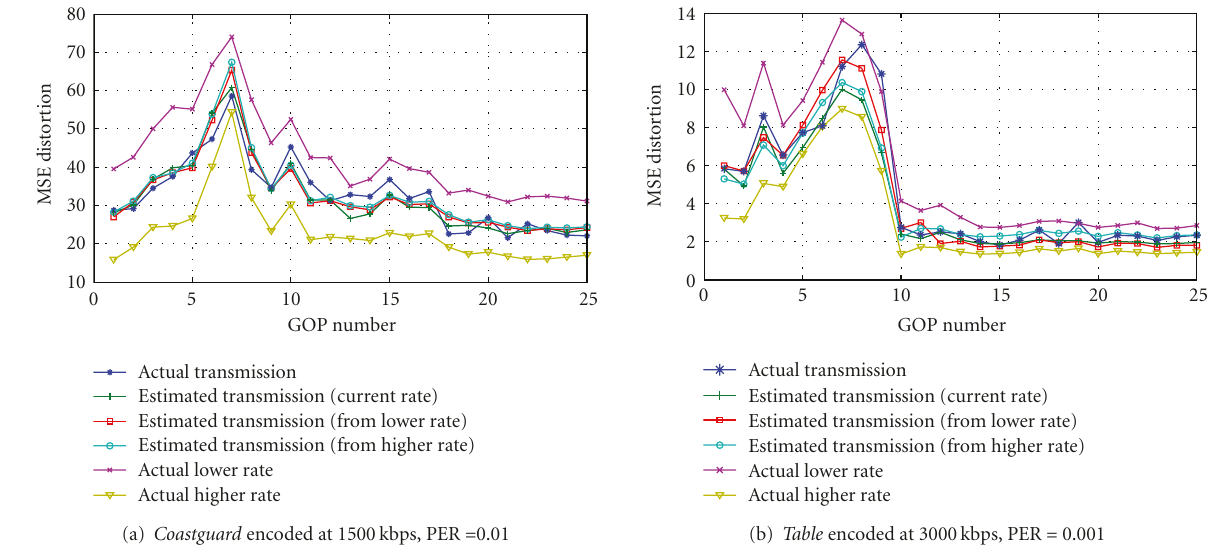
Figure 10: Estimated received distortion along the GOPs with fixed PER.